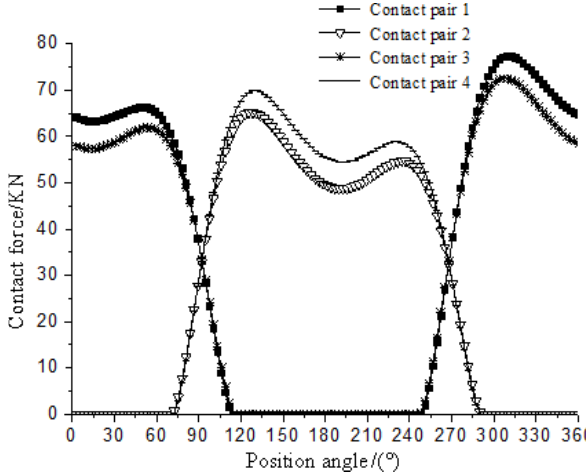
Figure 8: Contact force distribution in the bearing with flexible rings